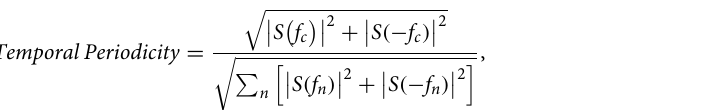
Figure 6. A diagram for temporospatial characterization with real-time cardiac